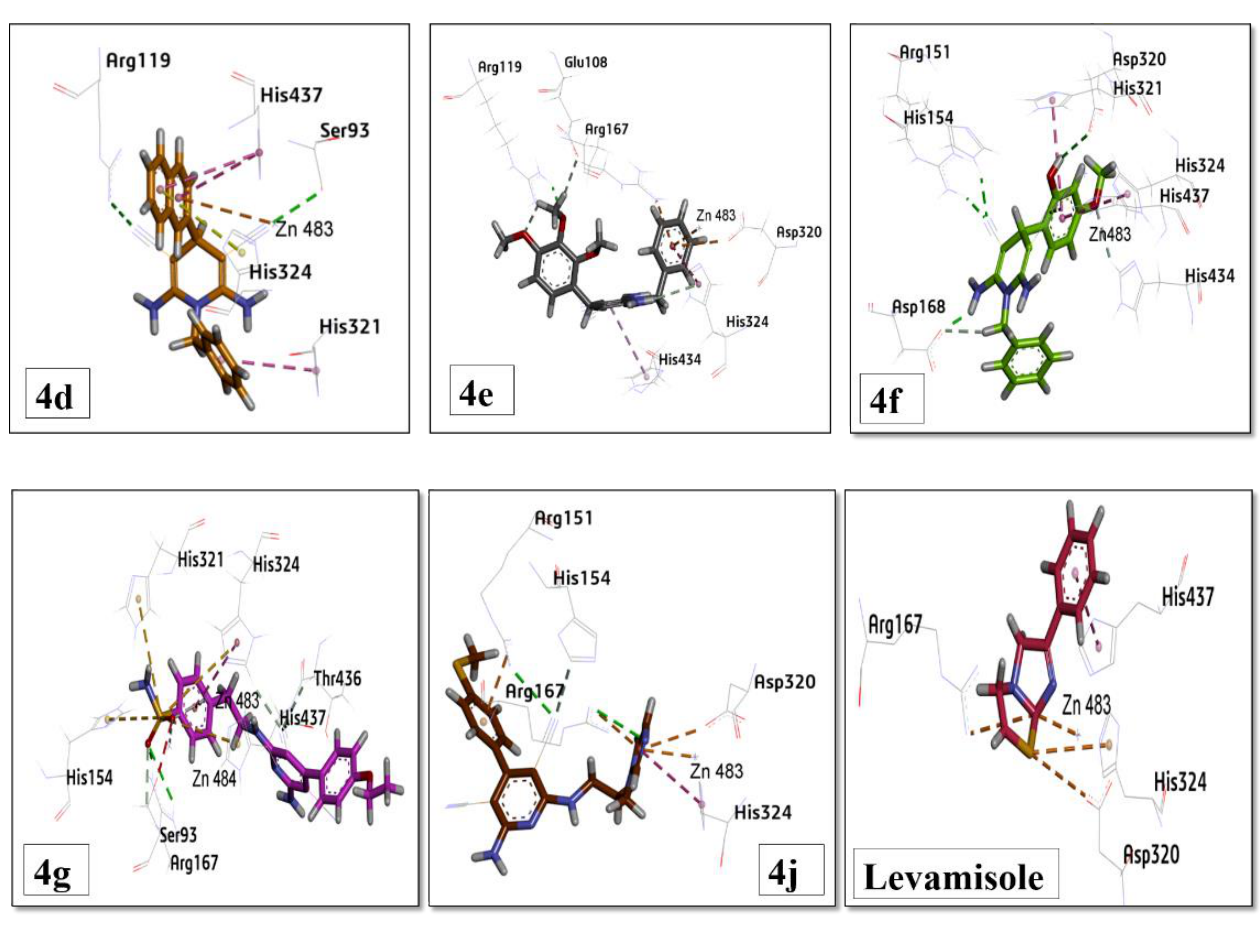
Figure 2. Mode of interaction of the compounds 4d , 4e – 4g, 4j, and standard drug (levamisole) with the amino acid residues of human nonspecific alkaline phosphatase ( h -TNAP) enzyme (3D-View).